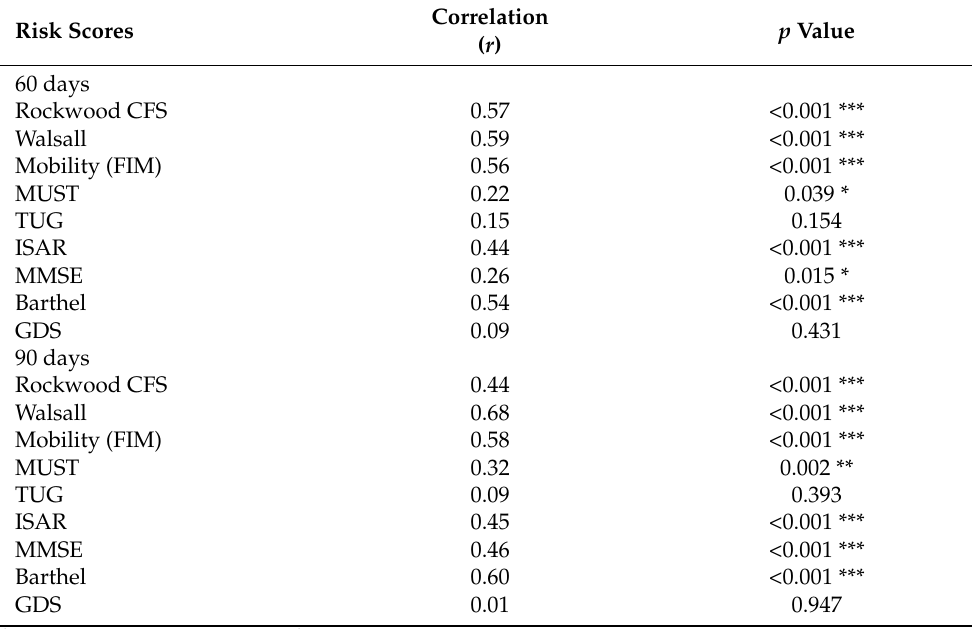
Table 5. Correlation between risk-prediction scores and remaining ‘unstable’ or ‘deteriorating’ at 60 days and 90 days (n = 88). Risk Scores